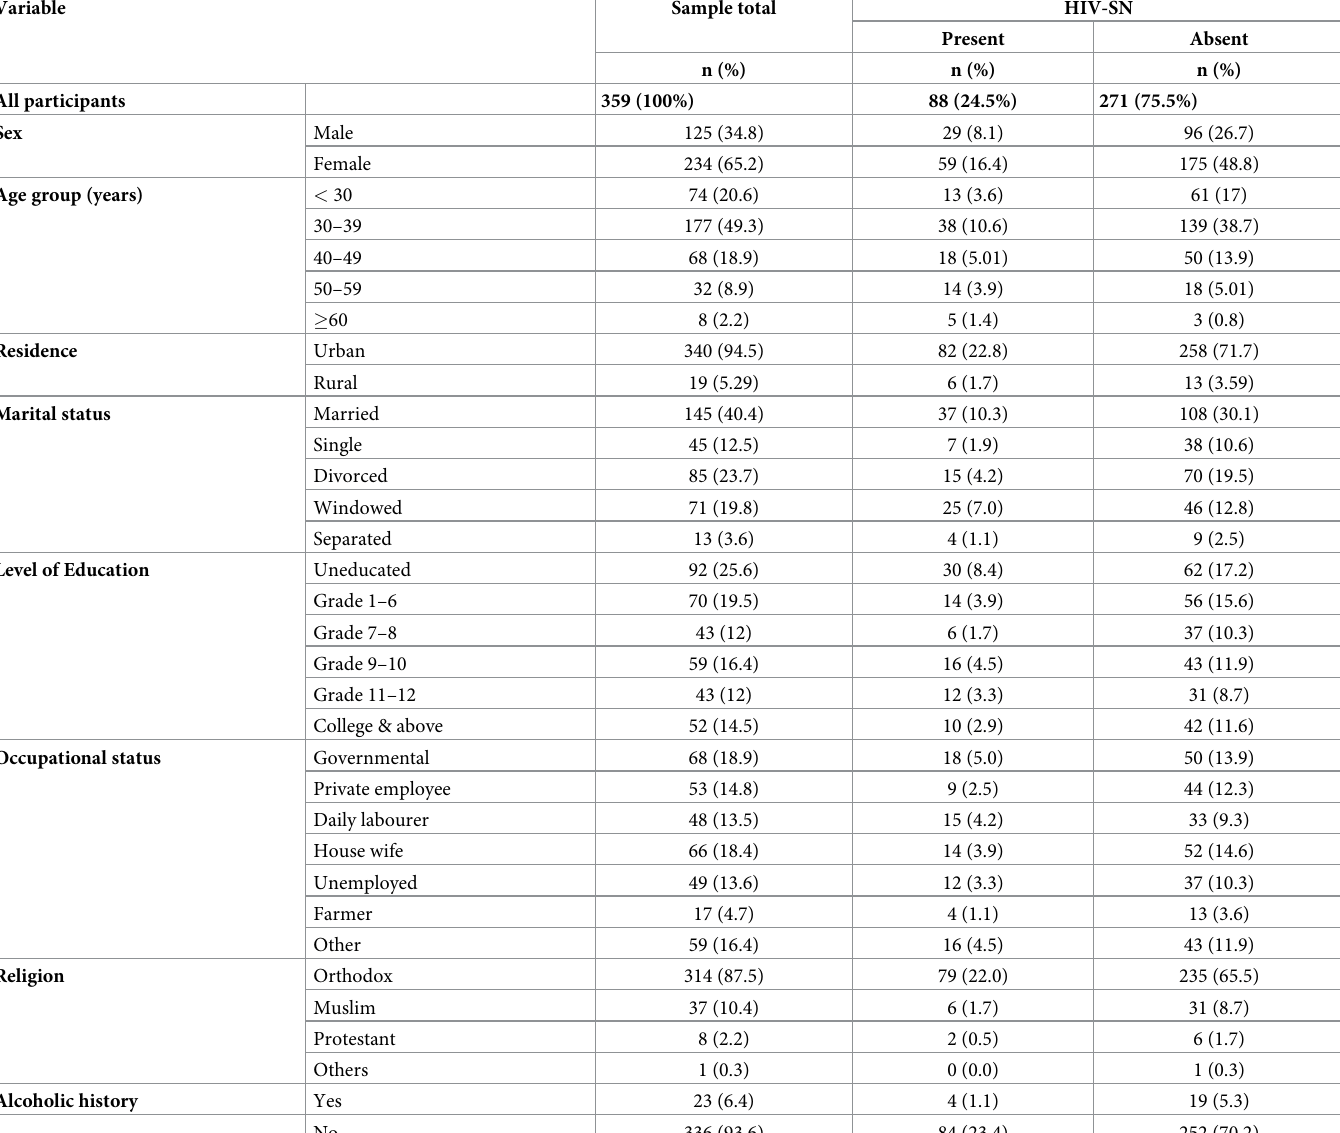
Table 1. Distribution of HIV-SN and socio-demographic characteristics of 359 patients living with HIV [PLHIV] who attended HIV care clinic, North West Ethio- pia,